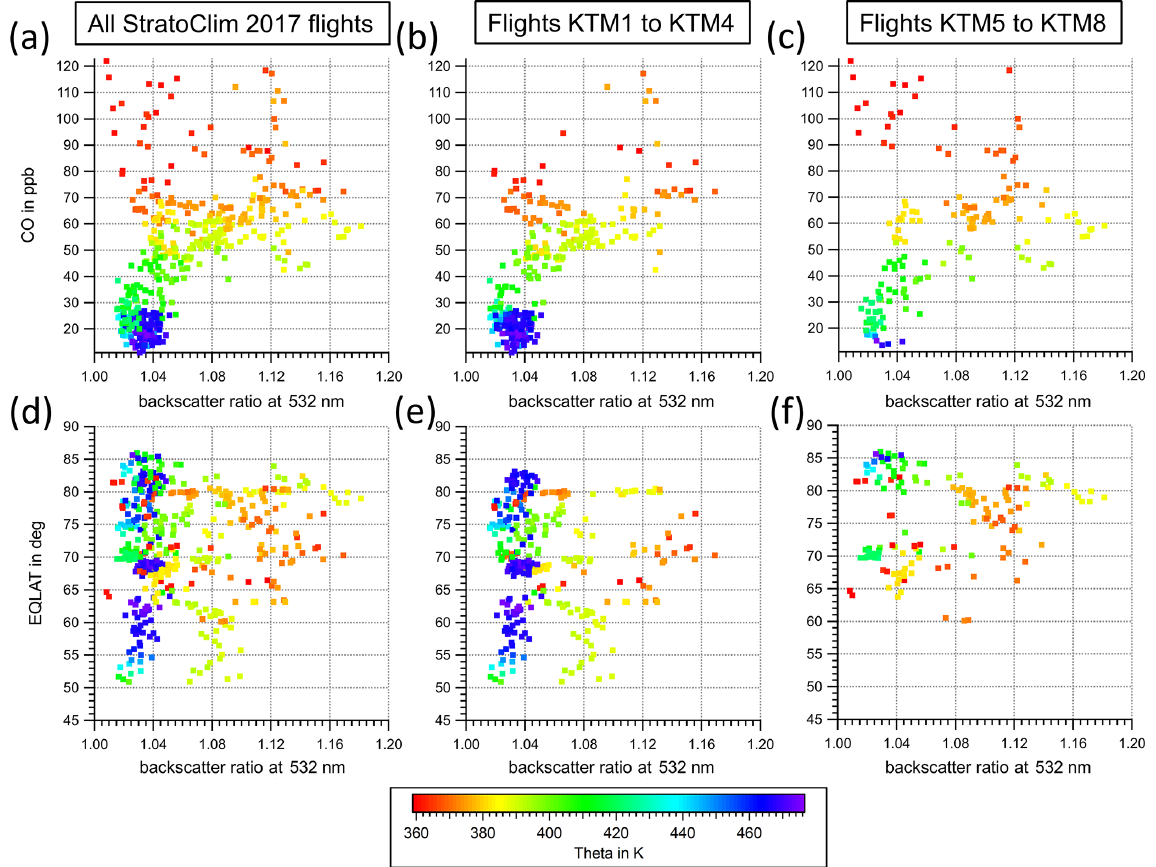
Figure 9. Scatterplots of the size-distribution-based BR with the CO mixing ratio (a–c) and the AMA-centered equivalent latitude (EQLAT) (d–f) . Panels (a) and (d) represent the full period of the 2017 StratoClim field campaign, panels (b) and (e) represent the first half of the campaign period (flights KTM1 to KTM4), and panels (c) and (f) represent the second half of the campaign period (flights KTM5 to KTM8). The potential temperature is color